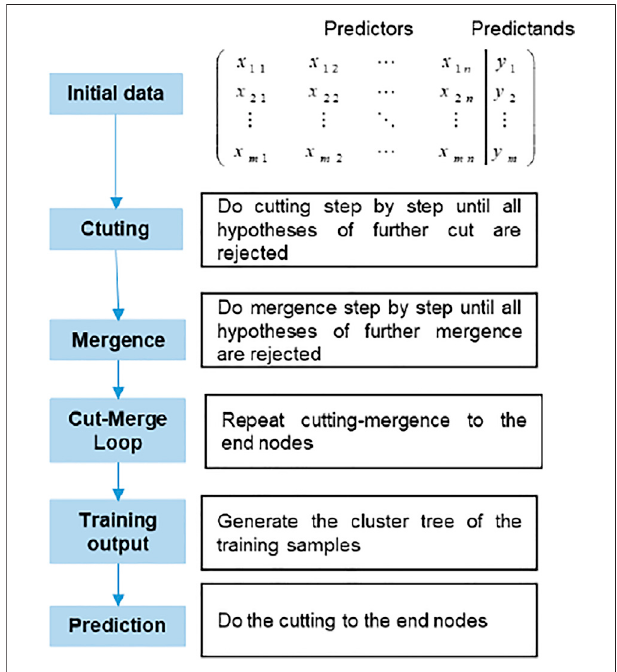
FIGURE 1 | The framework of